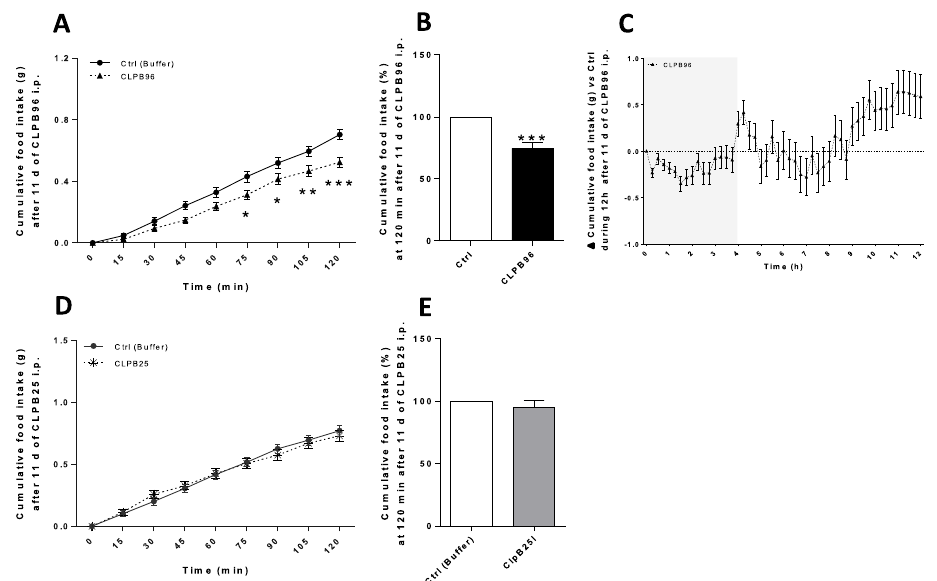
Figure 4. Effects of CLPB96 and CLPB25 on food intake in C57B1/6 2 h after daily intraperitoneal injection. Cumulative food intake (g) measured 2 h after daily injection ( A ) of CLPB96 or ( D ) CLPB25